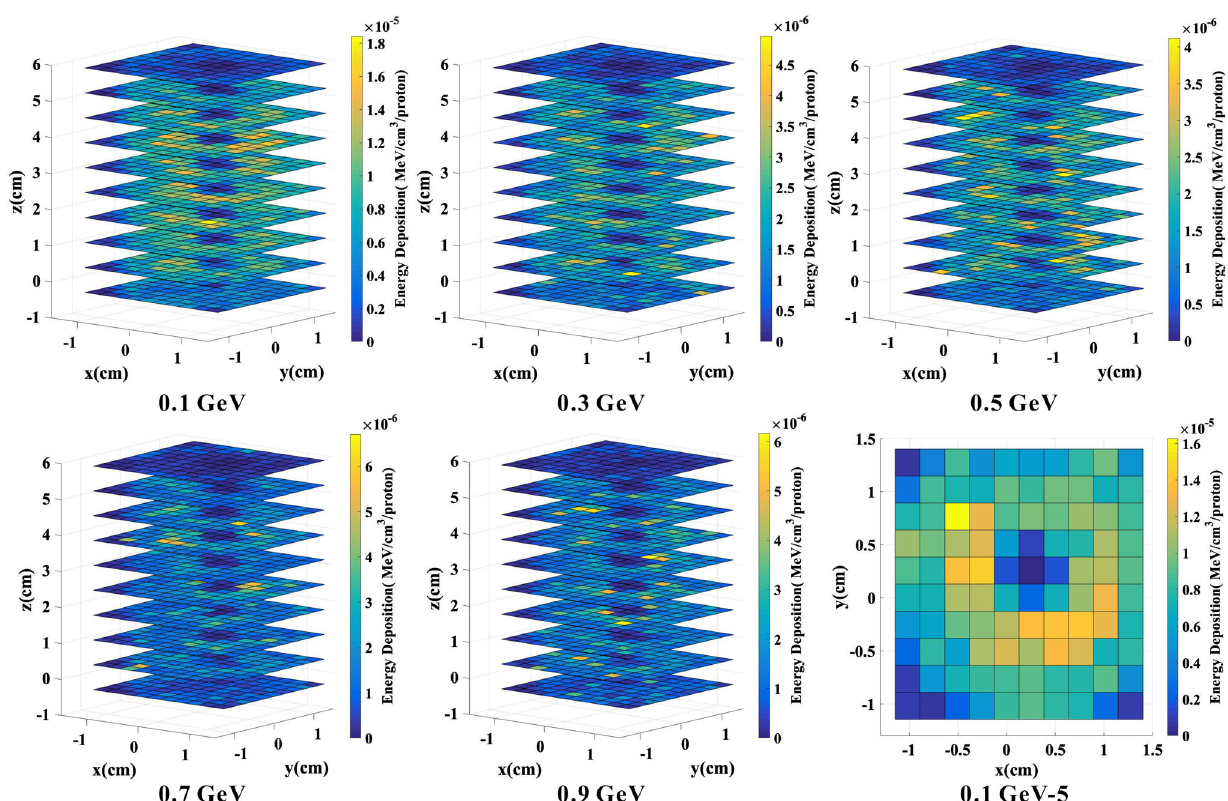
Fig. 5 Energy deposition diagram and local detail diagram at different positions